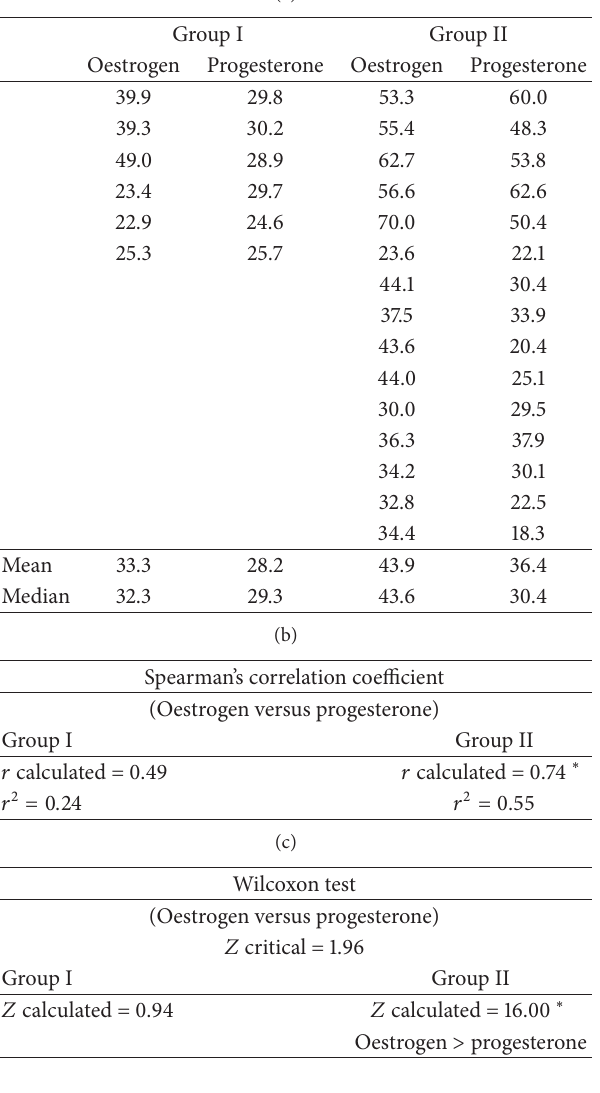
Table 2: Oestrogen and progesterone receptors in the myometrium of full-term pregnant women in labour (Group I) and full-term pregnant women not in labour (Group